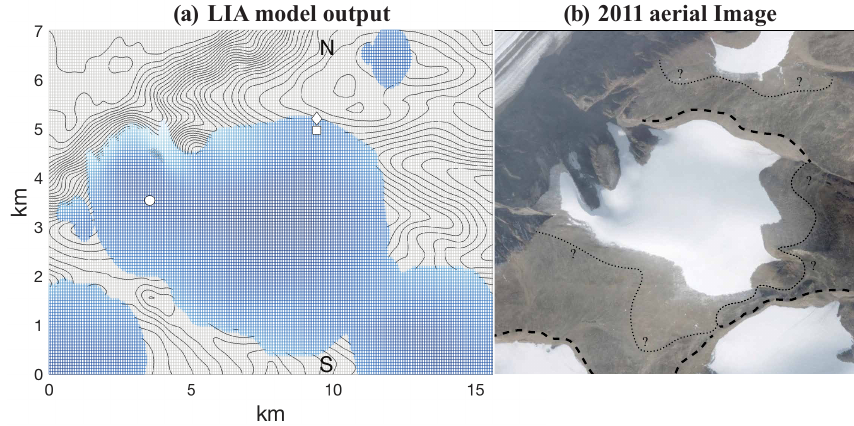
Figure 4. Map view of simulation (a) output showing the modeled maximum Neoglacial extent (contour interval is 30m, N and S show the north–south line along which the transect was modeled). Also shown is sample #12 (circle), 1000CE margin (square), and Neoglacial maximum trimline (diamond). Panel (b) shows a Google Earth 2011 image (most recent available) with Neoglacial maximum extent trimlines (dashed lines) and approximate trimlines (dotted lines) shown.